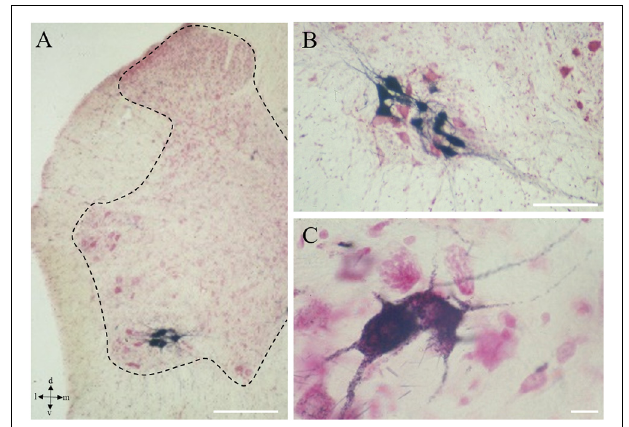
FIGURE 1 | Onuf’s nucleus motor neurons (MNs). Localization of Onuf’s MNs (in black those innervating ischiocavernosus muscle, in the dorsolateral column) in rat spinal cord, by horseradish-peroxidase retrograde transport, at low (A) and high magnification (B,C) , in a neutral red-stained section. Dendrites form characteristic dendritic bundles. The dotted line in panel (A) outlines the gray matter. Scale bars: 100 µ m in panels (A,B) , 10 µ m in panel (C) .